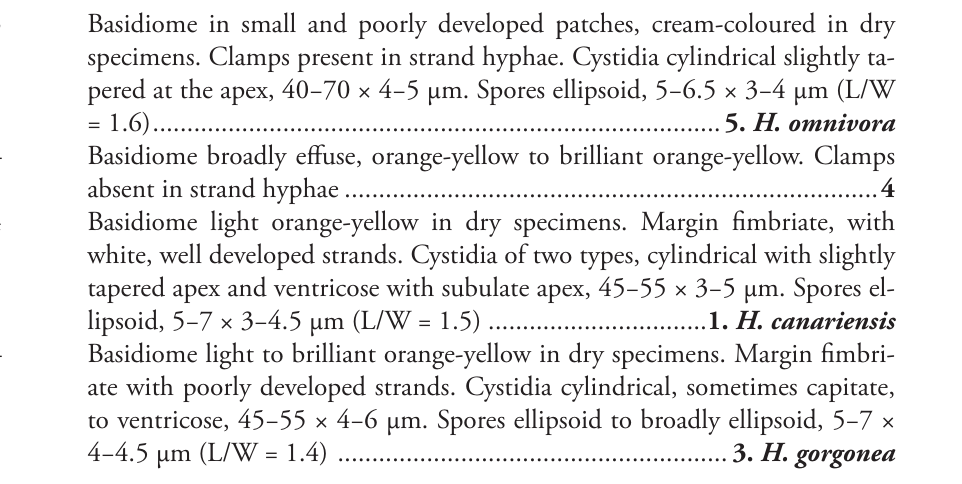
Basidiome in small and poorly developed patches, cream-coloured in dry specimens. Clamps present in strand hyphae. Cystidia cylindrical slightly ta- pered at the apex, 40−70 × 4−5 μm. Spores ellipsoid, 5−6.5 × 3−4 μm (L/W = 1.6) ................................................................................... 5. H. omnivora